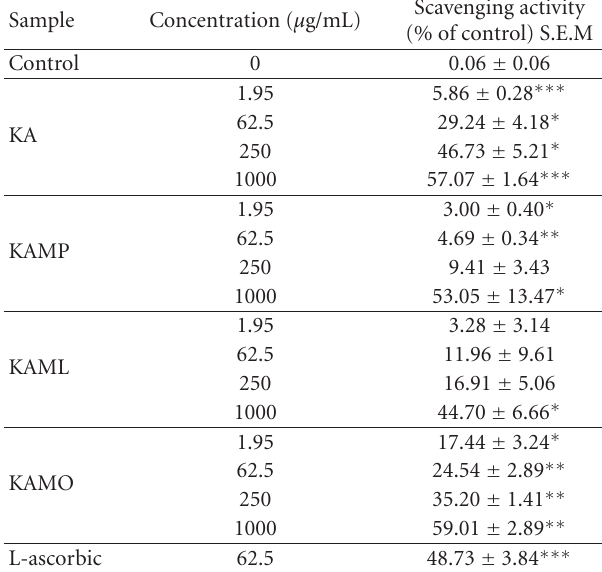
Table 3: Antioxidant e ff ects of KA, KAMP, KAML and KAMO using to untreated control. Data are presented as means ± S.E.M, and expressed as % of control, n ≥